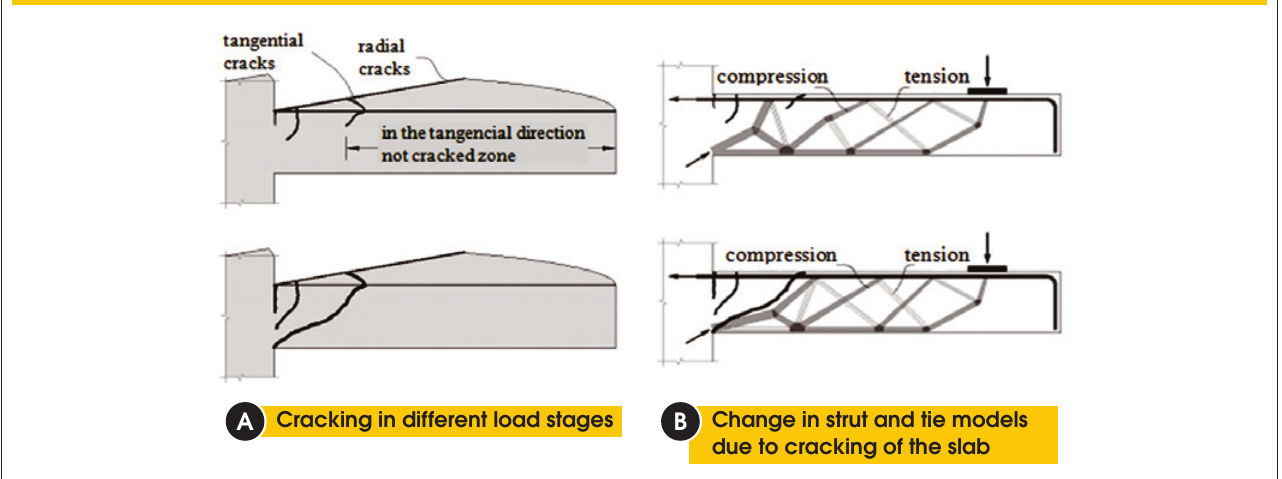
Figure � � �tructural beha�ior of slab�column connections after cracking ��uttoni and �ch�art�